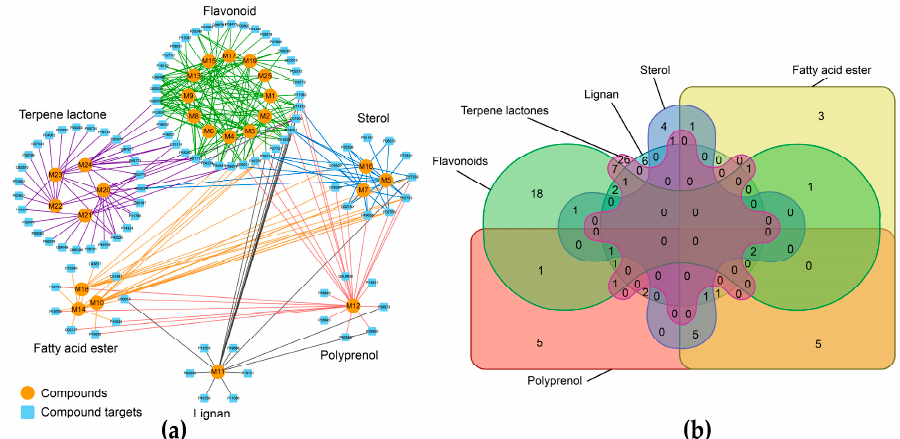
Figure 2. The 2D molecular structures, names, and codes of the 25 candidate compounds.